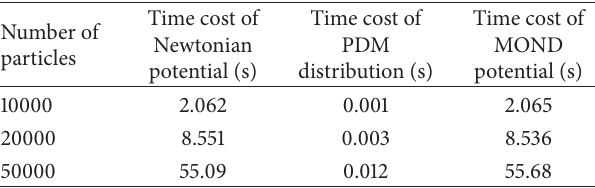
Table 1: Time cost of MOND calculation on Intel i5